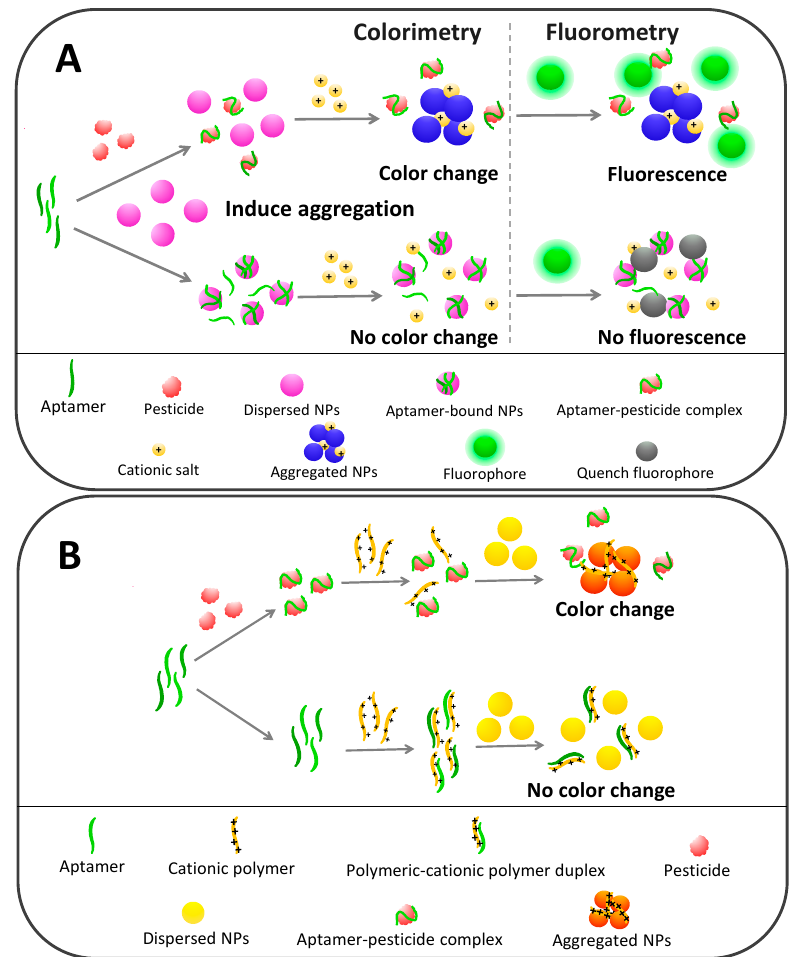
Figure 3. Schematic representation of general concept of nanoparticle-based colorimetric aptasensors for pesticide detection. ( A ) Color production is realized by salt-induced nanoparticle (NP) aggregation, which can be further extended to a fluorometric system by NP-induced fluorescence quenching. ( B ) Important role of cationic polymers in triggering NP aggregation in colorimetric pesticide aptasensors.